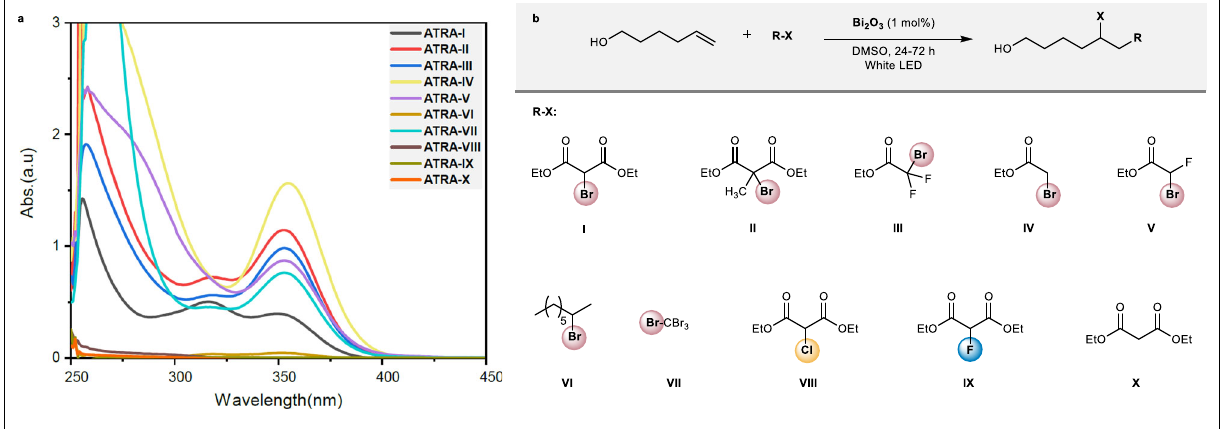
Fig. 3 Substrate probe for the Bi 2 O 3 -induced ATRA reaction. a UV – vis analysis of the reaction crudes in the Bi 2 O 3 -promoted ATRA reaction of 5-hexen-1- ol with a variety of ATRA donors ( I – X ). b Employed ATRA donors. Compounds VI , VIII , IX , and X failed to